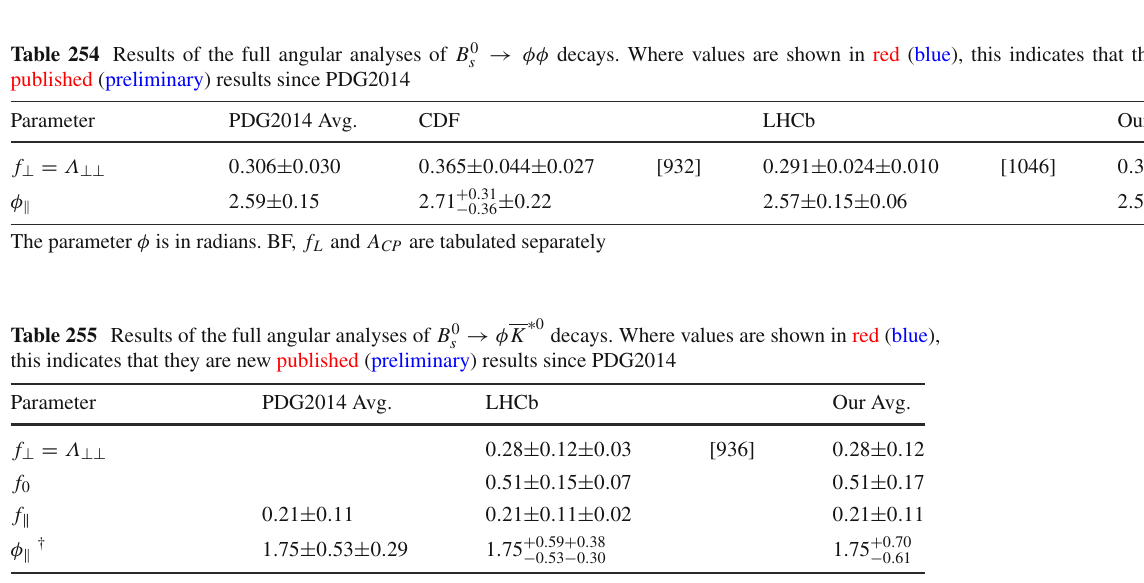
Table 254 Results of the full angular analyses of B 0 s → φφ decays. Where values are shown in red (blue), this indicates that they are new published (preliminary) results since PDG2014 Parameter